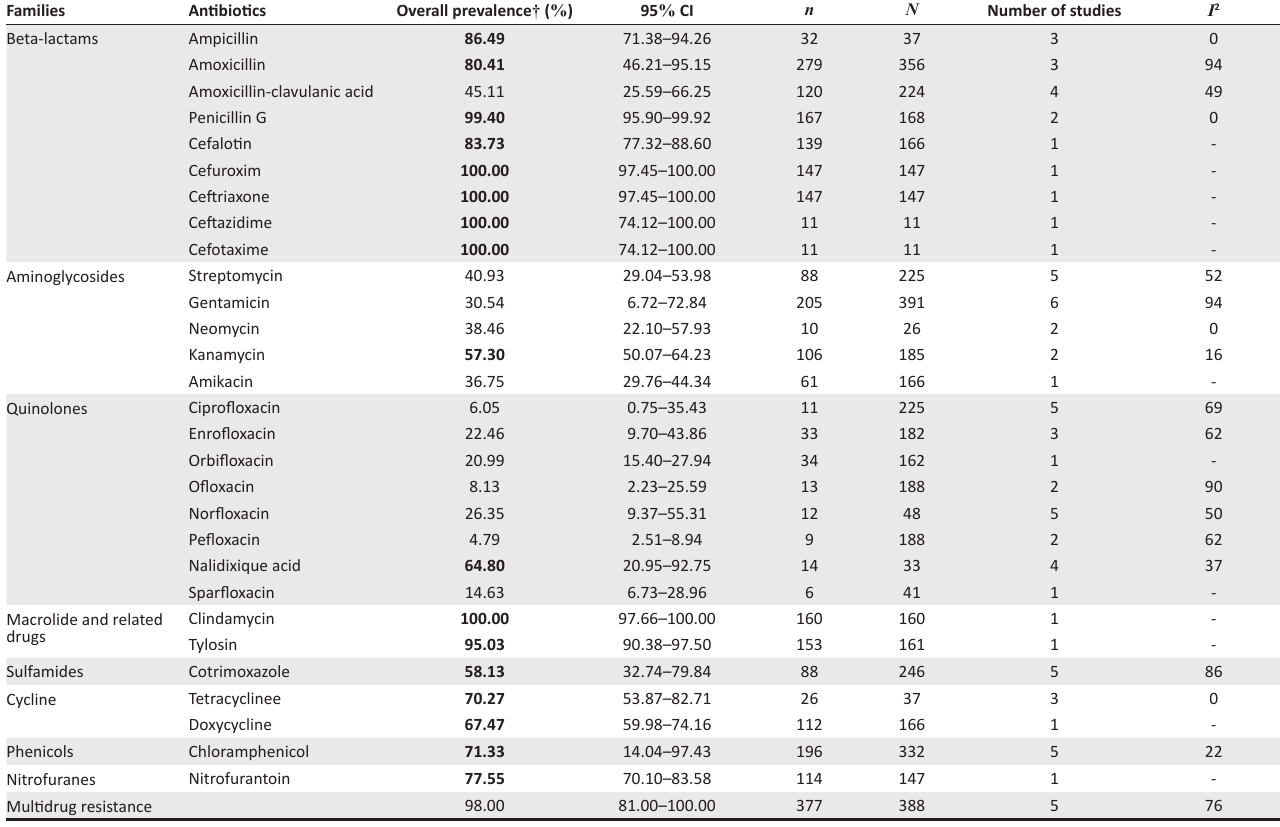
TABLE 3: The overall prevalence of antibiotic resistant Escherichia coli strains isolated from dogs in Africa. Families